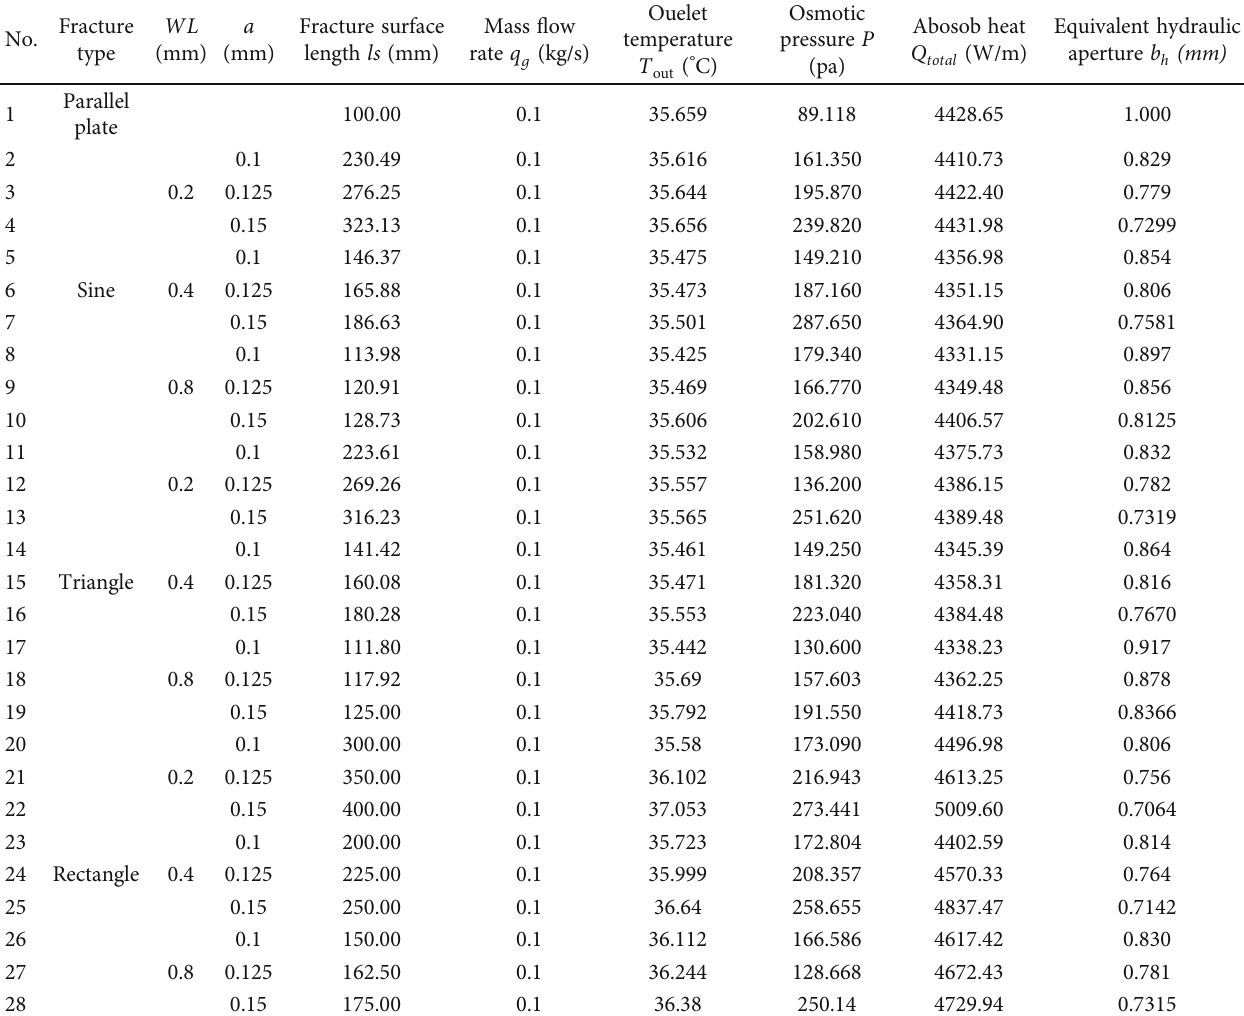
Table 2: Numerical results of fl ow heat transfer in